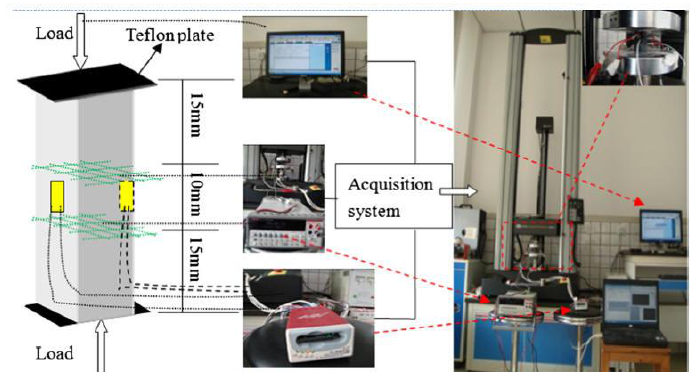
Figure 26. Sketch of measuring piezoresistivity of GRCCMs. Reprinted with permission from